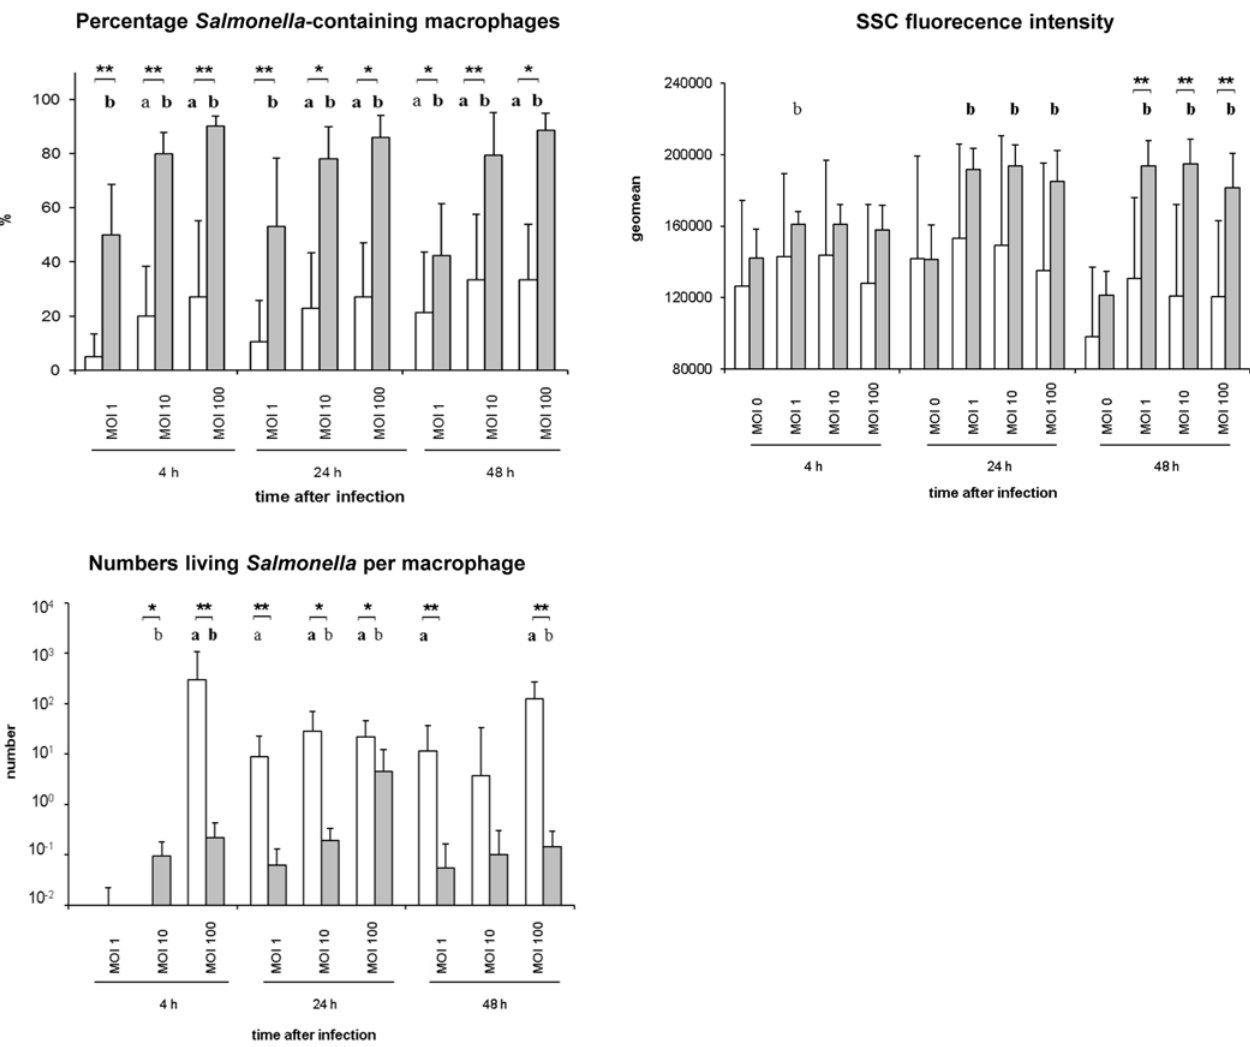
Fig 3. Quantification of Salmonella -containing macrophages (flow cytometry) and numbers of intracellular bacteria (microbiology). The percentage of avian macrophages containing intracellular Salmonella was analyzed by flow cytometry after staining with an anti- Salmonella LPS antibody. Additionally, the SSC fluorescence intensity, which correlates with the Salmonella invasion/uptake, was determined after Salmonella infection of the primary macrophages. Numbers of viable intracellular Salmonella per avian macrophages were determined using bacteriology. White columns — macrophages infected with S . Typhimurium (n = 8), Grey columns — macrophages infected with S . Infantis (n = 6) ** P (cid:2) 0.05 or * P (cid:2) 0.1 S . Typhimurium vs. S . Infantis; a ) P (cid:2) 0.05 or a) P (cid:2) 0.1 S . Typhimurium vs. control; b ) P (cid:2) 0.05 or b) P (cid:2) 0.1 S . Infantis vs. control.